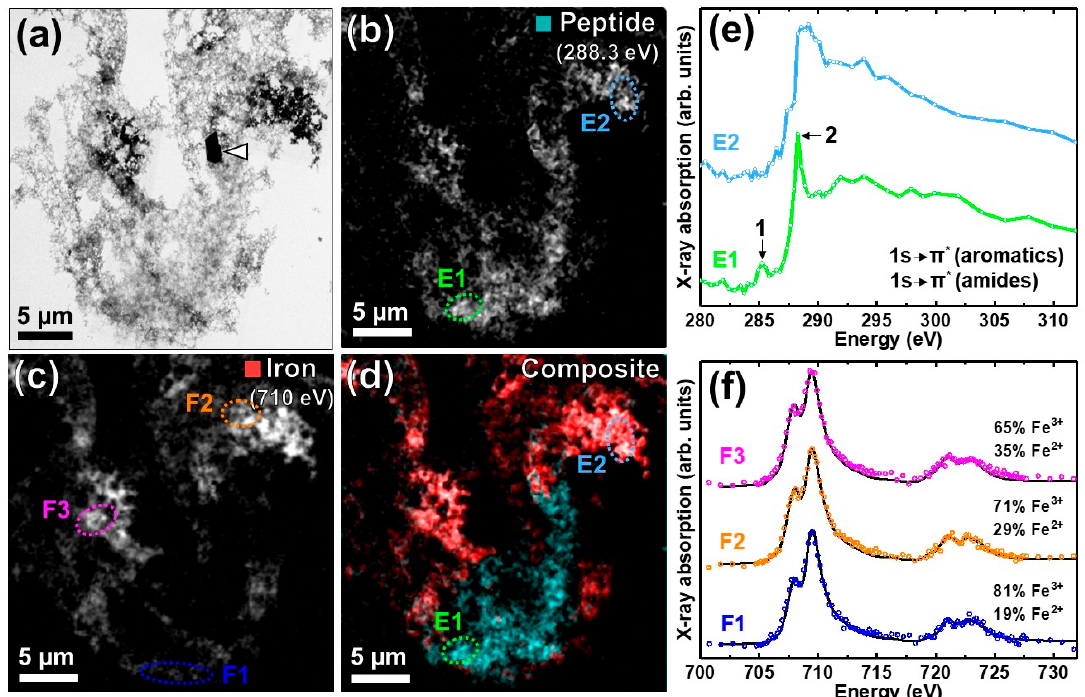
Figure 3. TEM and STXM analysis of an A β /iron aggregate formed in-vitro. ( a ) TEM image. Arrowhead shows a crystalline artefact originating from the buffer medium. ( b ) Carbon K -edge peptide speciation map. ( c ) Iron L 3 -edge speciation map. ( d ) Composite image displaying peptide (cyan) and iron (red) content of the aggregate. (e) Carbon K -edge x-ray absorption spectra from the aggregate regions highlighted in ( b ) and ( d ). ( f ) Iron L 2,3 -edge x-ray absorption spectra (colored circles) from the aggregate regions highlighted in ( c ). The solid lines for the spectra correspond to the best fit curve created by superposition of suitably scaled iron reference x-ray absorption spectra.